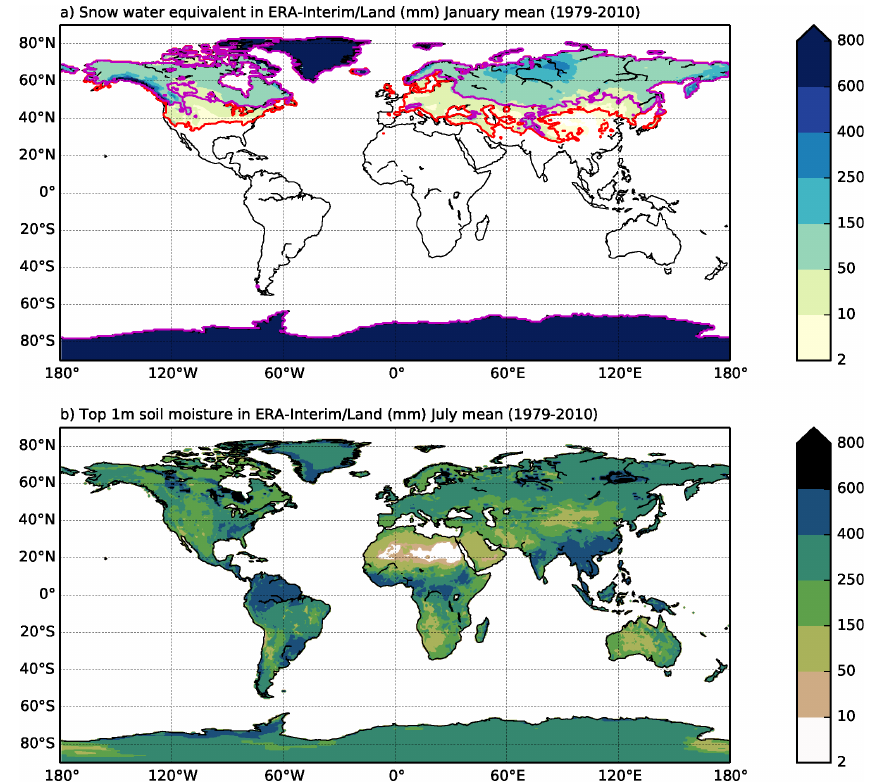
Figure 3. Same as Fig. 2, but for